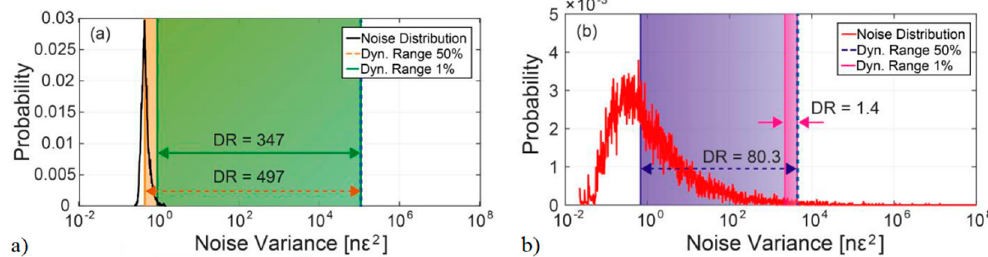
Figure 14. (From [44]): Noise distribution and dynamic range of the sensor: ( a ) CP- Φ OTDR; ( b ) coherent-detection Φ OTDR. Vertical dashed lines at the right point out the maximum shot-to-shot measurable perturbation. Green and pink shaded rectangles mark the limits of dynamic range assuming 1% of noisy measurements (SNR ≤ 1); yellow and purple rectangles mark the limits of dynamic range for 50% of noisy measurements, @2018 IEEE [44].